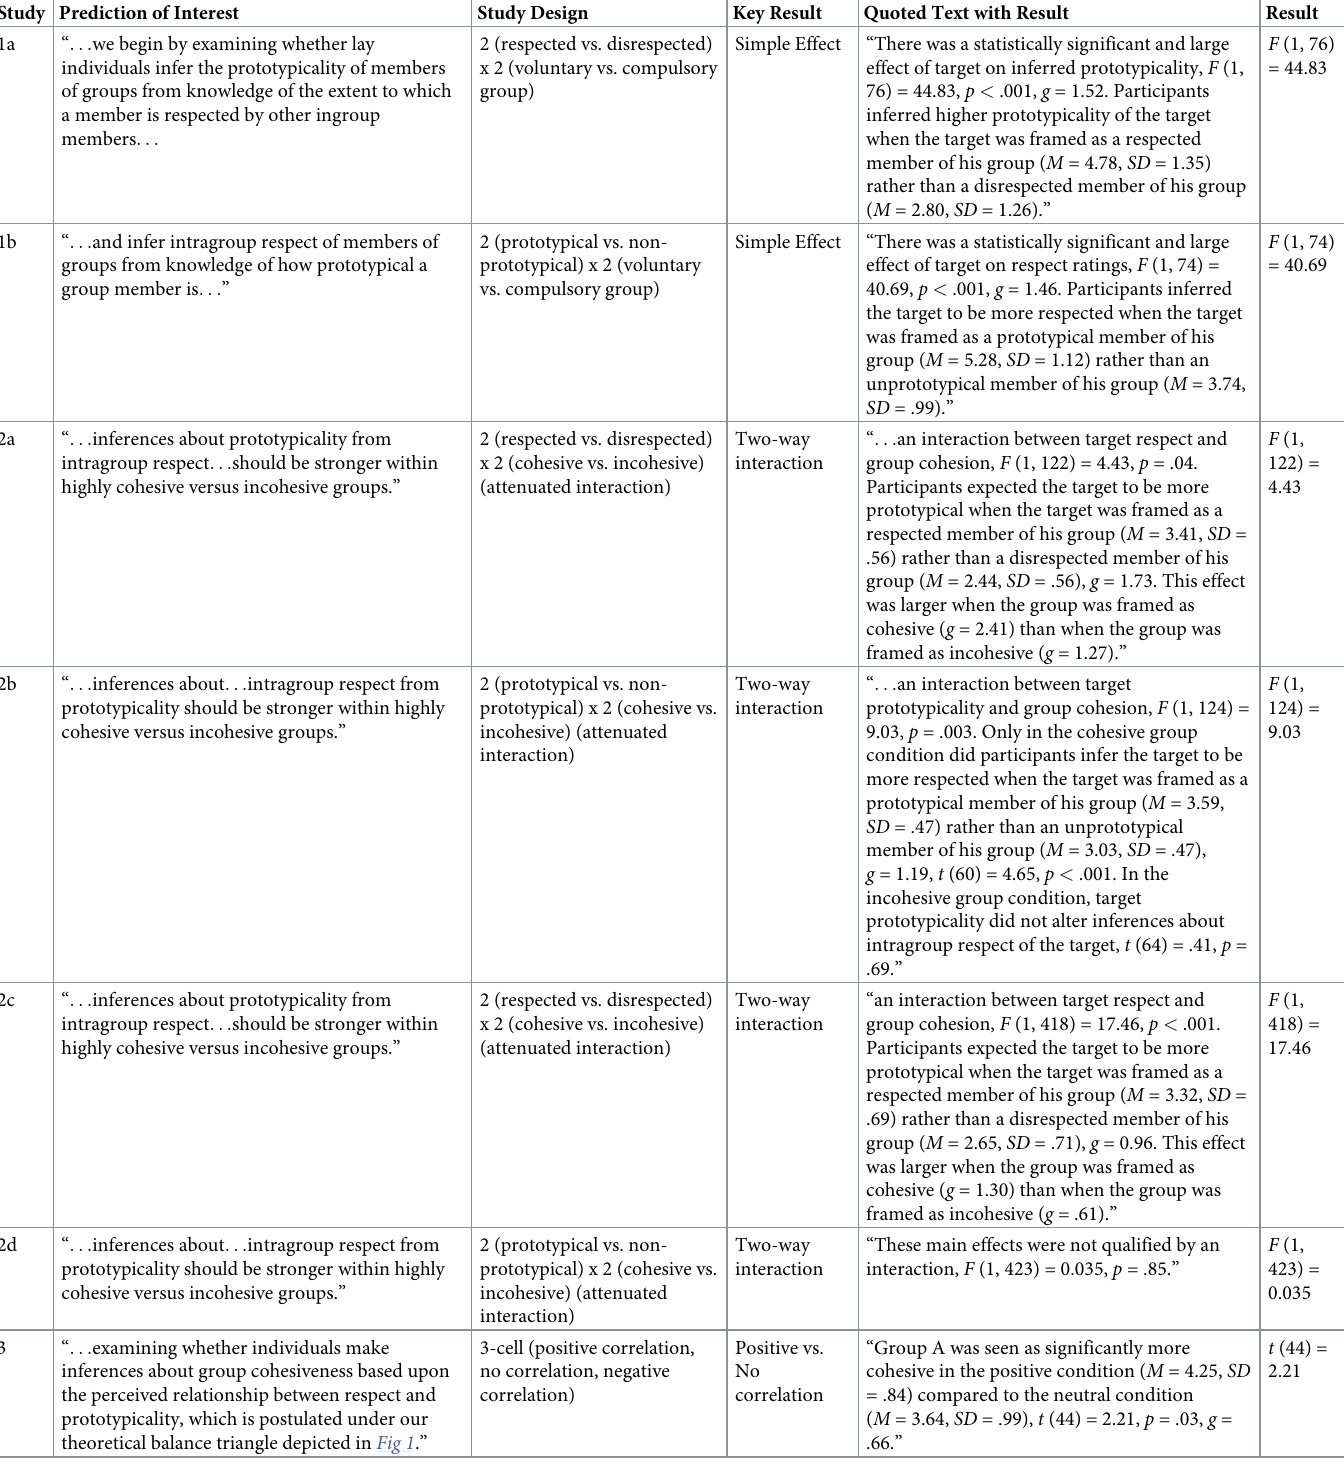
Table 1. Summary of